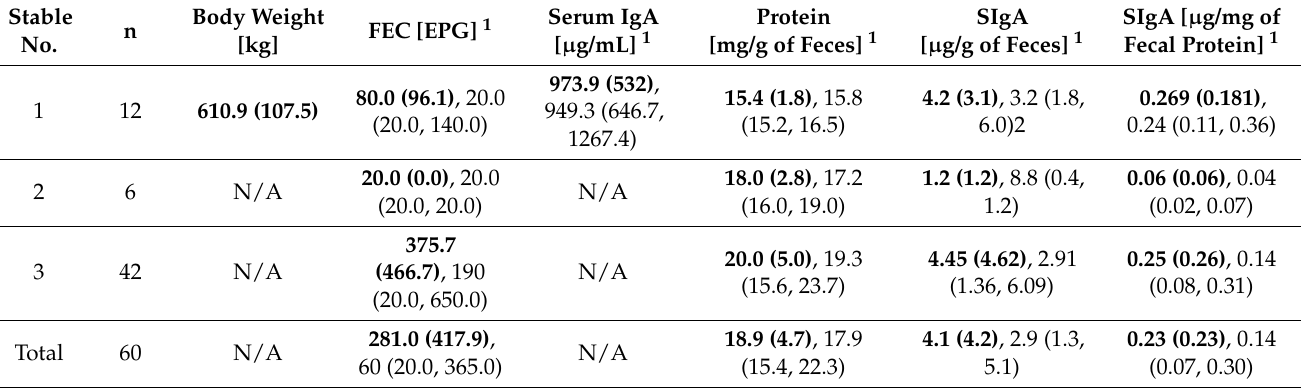
Table 2. The results of the tests for fecal egg count (FEC), serum IgA, SIgA and fecal protein